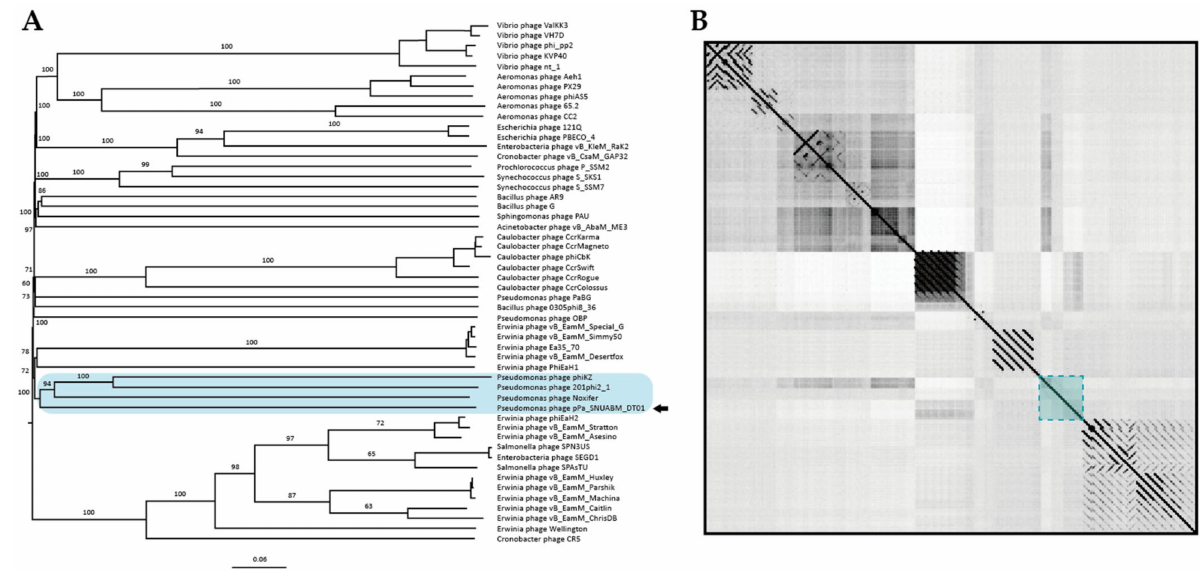
Figure 4. Whole genome comparison of the pPa_SNUABM_DT01 genome and jumbo-phages. Skyblue box: the cluster including pPa_SNUABM_DT01. ( A ) Phylogenetic tree constructed using VICTOR with genome sequences of jumbo-phages. ( B ) Dot plot constructed with concatenated genome sequences used in phylogeny.